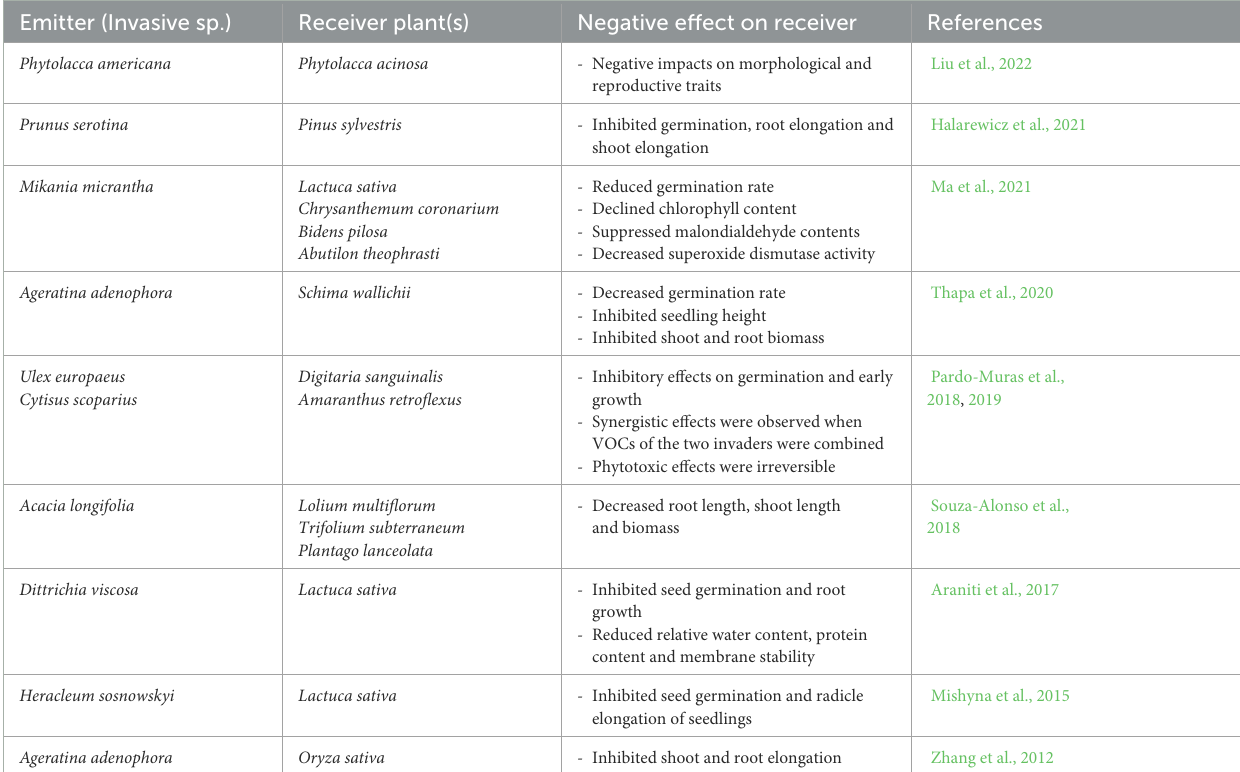
TABLE 1 Studies exploring the effect of invasive plants aboveground VOCs on recipient plants during the last decade (see search criteria). Emitter (Invasive